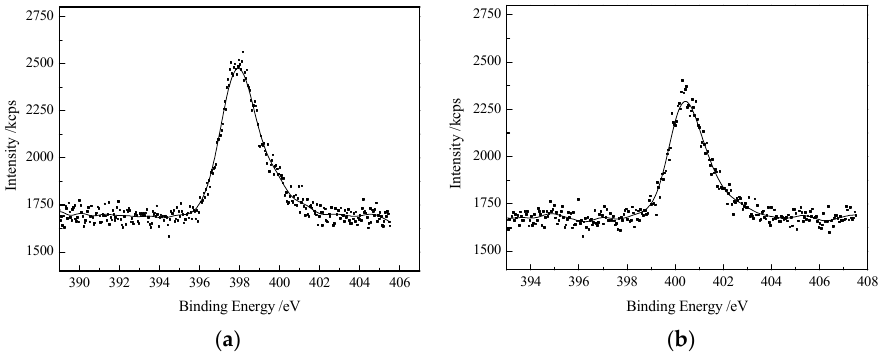
Figure 2. The binding energy curves of fuel nitrogen in synthetic coal samples. ( a ) Synthetic coal “M6”; ( b ) Synthetic coal “M5”.